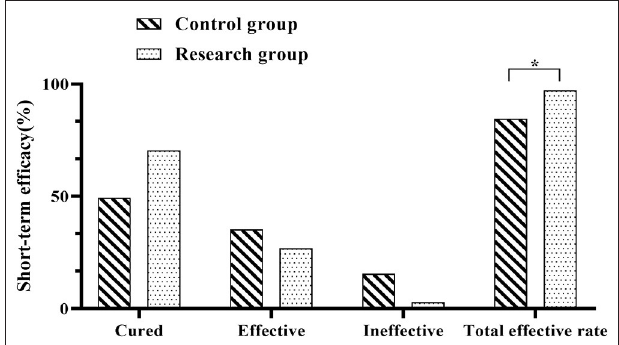
Frontiers in Surgery |